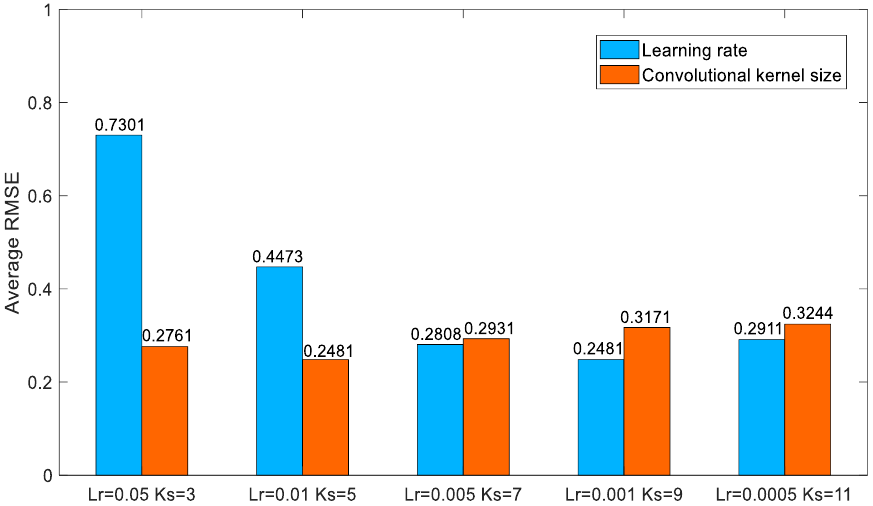
Figure 11. Learning rate and convolutional kernel size finding process.